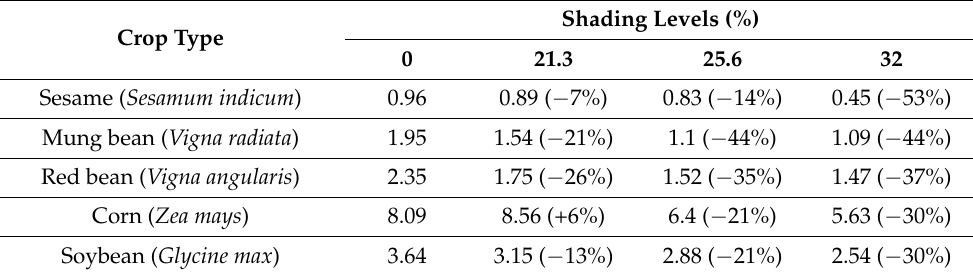
Table 3. Harvested grain yields (Mg/ha) of all five crops grown under four different shading levels